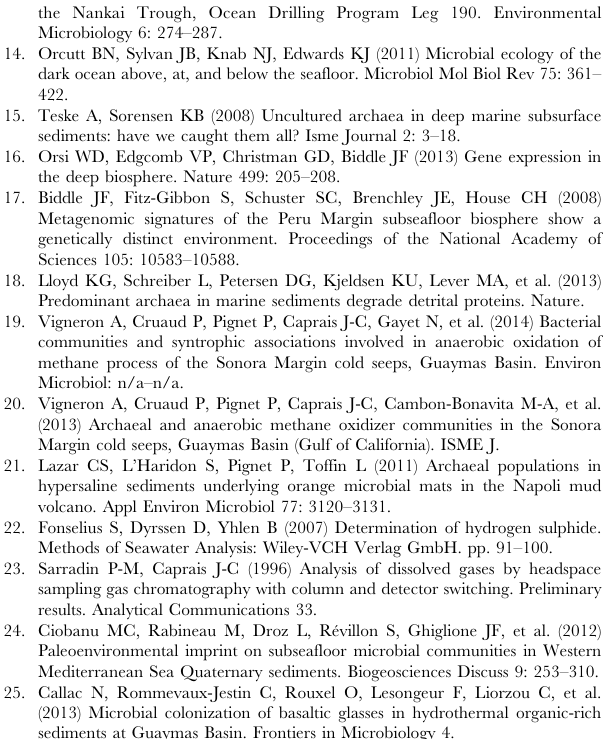
shown. Number in brackets shown the number of clones analyzed from RNA clone libraries. Table S1 Primer sets and annealing temperatures used for real- time PCR of 16S rRNA gene. Table S2 Details of GeoChip-targeted genes, related proteins and processes corresponding to each identified metabolic path- ways. Table S3 Correlation statistical tests and associated P values for microbial lineages and elementary composition of the sediment pore-waters. (DOC) Methods S1 Detailed methods for methanogenesis activity measurements, gene library constructions and phylogenetic affiliations, Q-PCR and ARISA